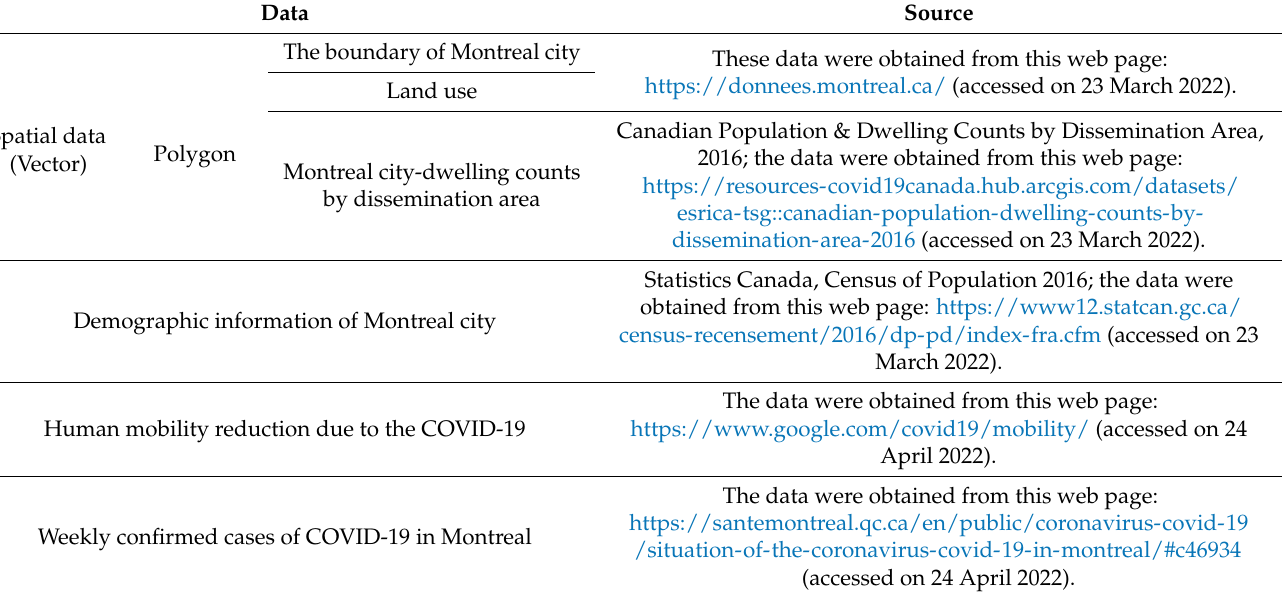
Table 2. Summary of the input